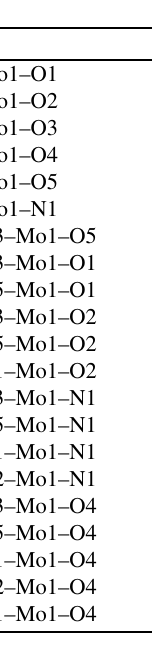
Table 2. Selected Bond Lengths (Å) and Angles (°) for the Com-